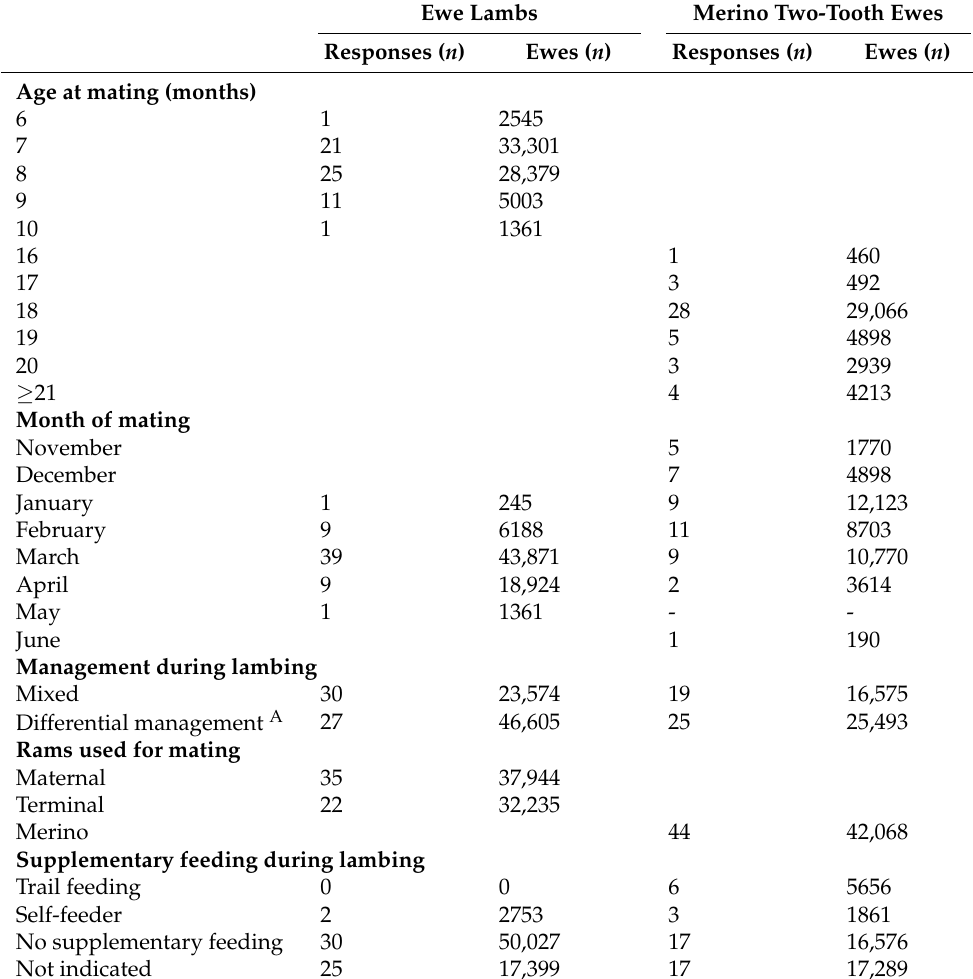
Table 2. Maiden ewe management characteristics based on eligible survey responses showing number of responses and number of ewes managed by respondents.